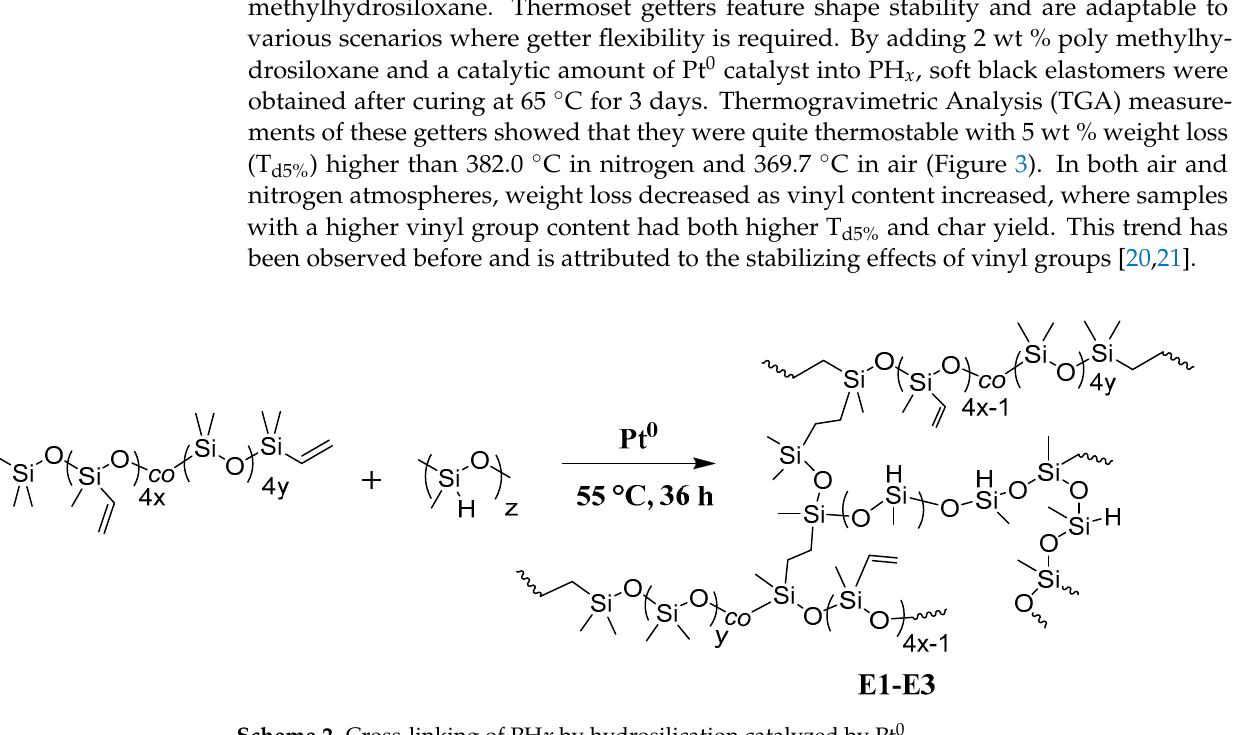
Figure 3. TGA curves of getter elastomer EH x ( x = 1, 2, 3) in N 2 ( a ) and in air ( b ). Stress-strain testing of the samples demonstrated a maximum tensile strength of about 0.4 MPa and a break elongation of about 120% (Table S1). Reactivity of the cured getters was also evaluated by testing in pure and dilute hydrogen atmospheres. Com- pared with the results for the PH x samples, the capacities of all EH x samples were reduced (Figure 4).